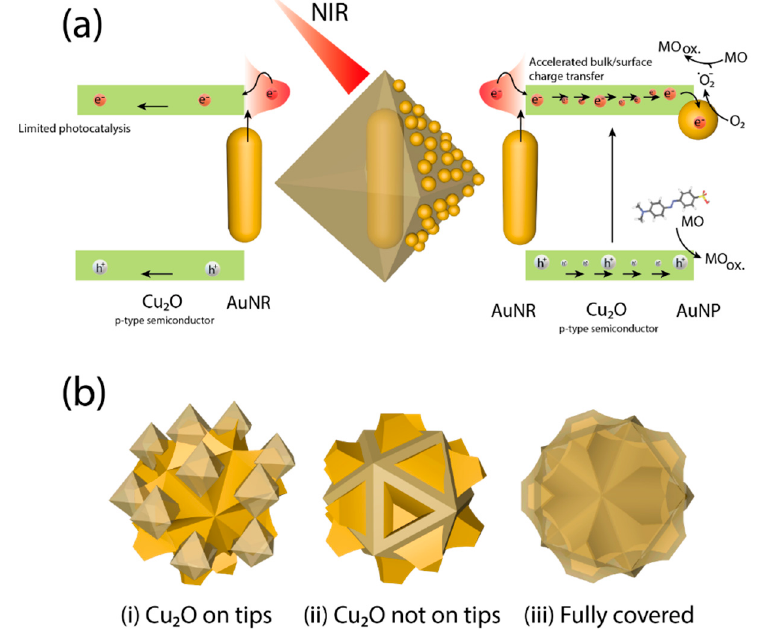
Figure 8. ( a ) Schematic mechanism for methyl orange (MO) photodegradation comparing the binary (left) from the ternary core-shell configuration (right) containing a plasmonic AuNR core, an octahedral Cu 2 O shell and an additional layer of small AuNPs for the ternary alternative (adapted from [113]); ( b ) Selective Cu 2 O deposition on AuNSs (adapted from [60]).